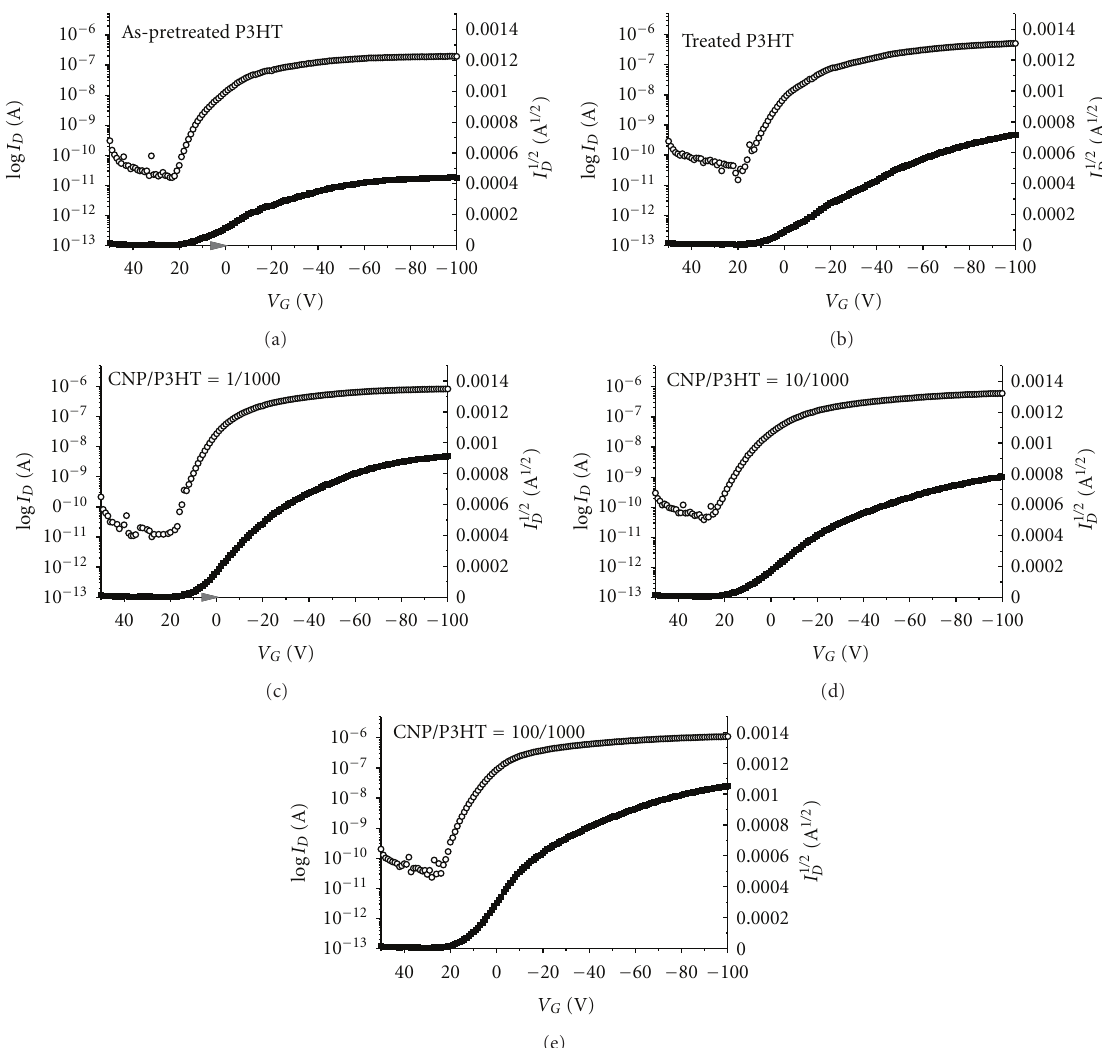
Figure 2: The I D -V GS of fabricated OFETs. (a) Pristine P3HT without O 2 plasma treatment; (b) pristine P3HT with O 2 plasma treatment; (c) CNP/P3HT = 0.1 wt.% with O 2 plasma treatment; (d) CNP/P3HT = 1wt.% with O 2 plasma treatment; (e) CNP/P3HT = 10wt.% with O 2 plasma